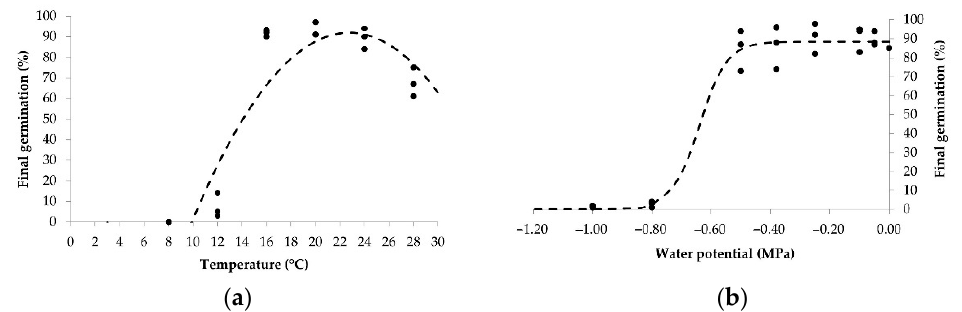
Figure 1. Estimated models of the final germination of Echinochloa crus-galli . A parabolic model was used to describe the effect of temperature ( a ), while a logistic model was used to describe the effect of water potential ( b ). The black dots represent the observed germination, while the dashed line represents the